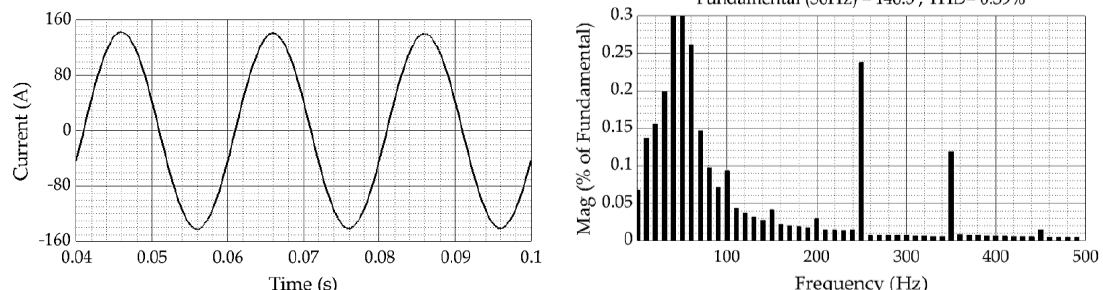
Figure 14. The input current waveform for Level 3 charging (Phase A).